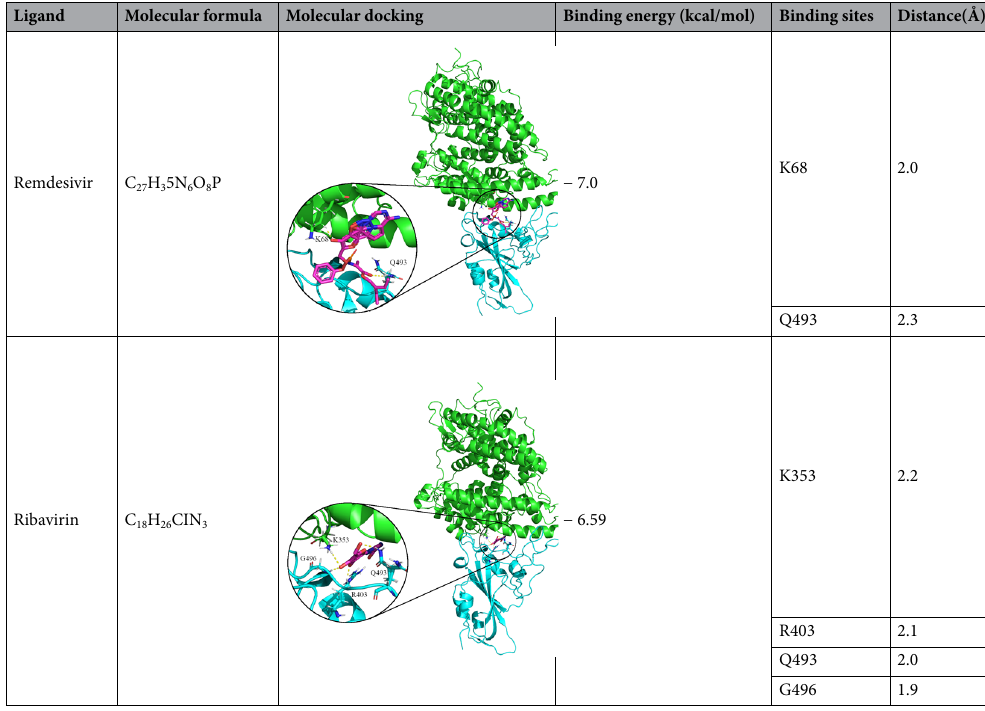
Table 8. Molecular docking between remdesivir and ribavirin and the SARS-CoV-2 spike (S) protein/ACE2.